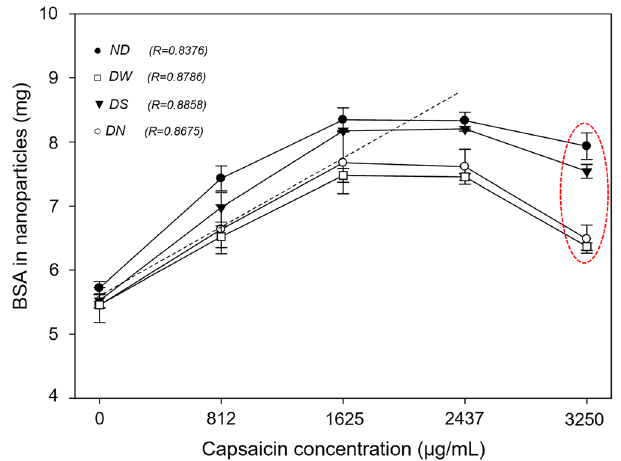
Figure 1. Effect of capsaicin concentration in the quantified BSA in nanoparticles subjected to drying treatments: not dried (ND), dried with water (DW), dried with sucrose (DS), and dried with NaCl (DN). All treatments showed a linear tendency for low concentrations. Values are means of three experimental replicates ± standard